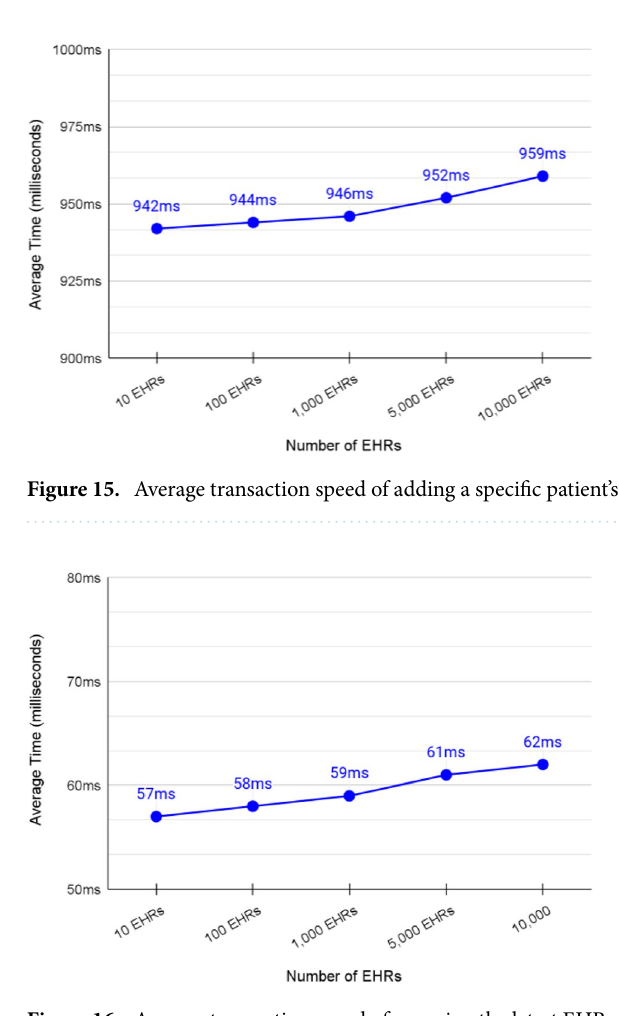
Figure 16. Average transaction speed of querying the latest EHRs page from the cache